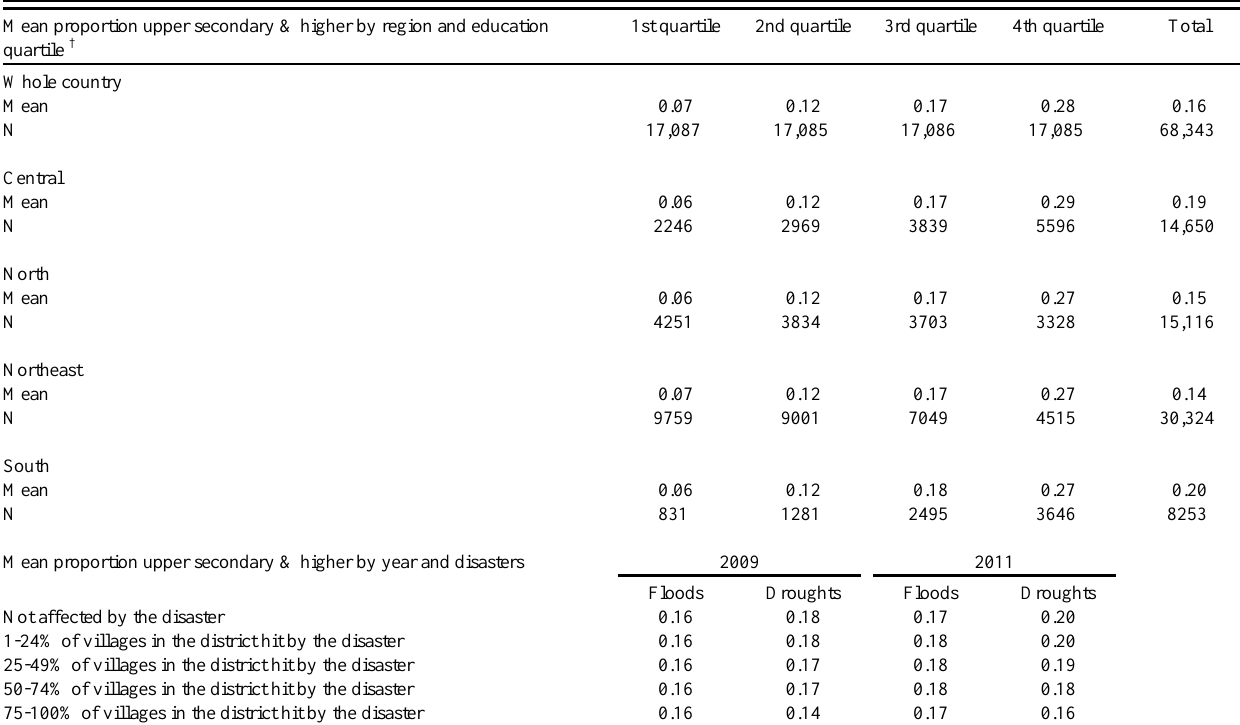
Table 2 . Mean proportion of village members with upper secondary education and higher by region and level of exposure to floods and